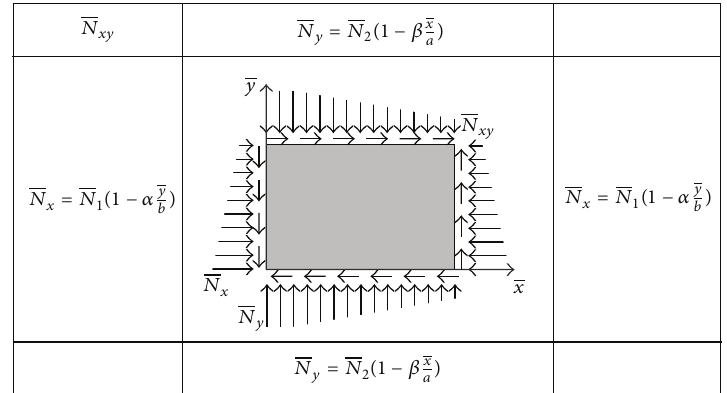
Figure 1: Rectangular vibrating plate subjected to in-plane loads: 𝑁 𝑥 , 𝑁 𝑦 , and 𝑁 𝑥𝑦